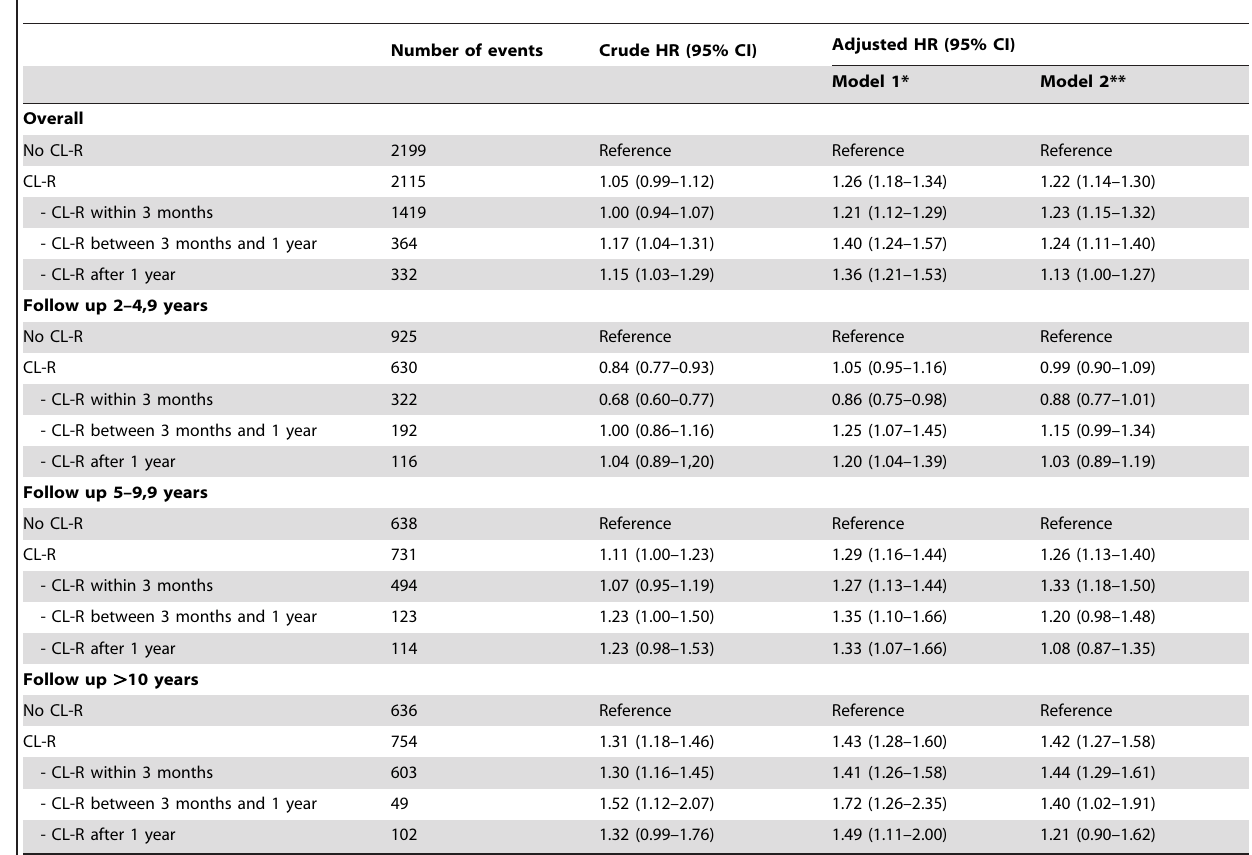
Table 3. Hazard ratio (HR) and 95% confidence interval (CI) for the association between crucial ligament reconstruction and knee osteoarthritis, according to follow-up and time of